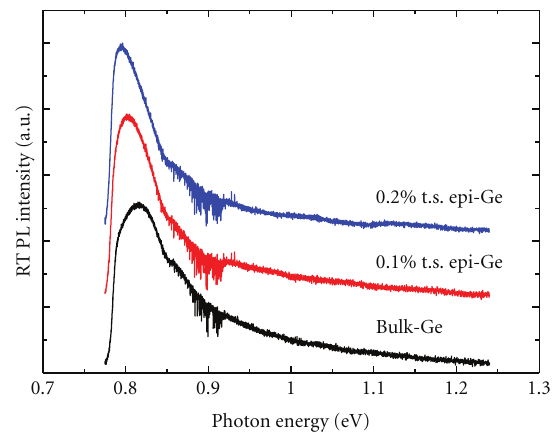
Figure 7: Room temperature photoluminescence of tensile- strained Ge on Si.